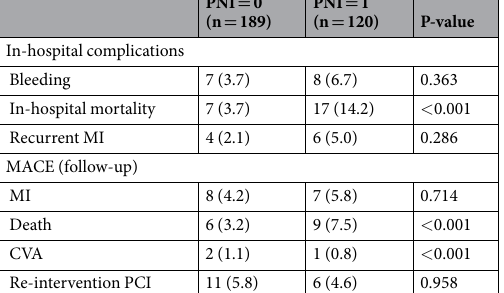
Table 4. Major adverse cardiac events in STEMI patients after pPCI by PNI score group. CVA, cerebrovascular accident; MACE, major adverse cardiac events; MI, myocardial infarction; PCI, percutaneous coronary intervention; PNI, prognostic nutritional index; STEMI, acute ST-segment elevation myocardial